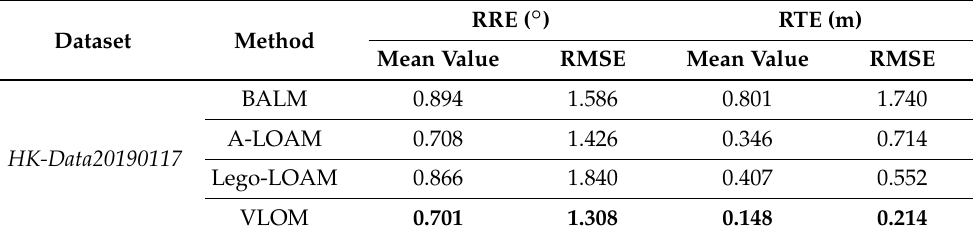
Table 1. RPEs of BALM, A-LOAM, Lego-LOAM, and VLOM produced by EVO on HK-Data20190117 . The values in bold indicate the best